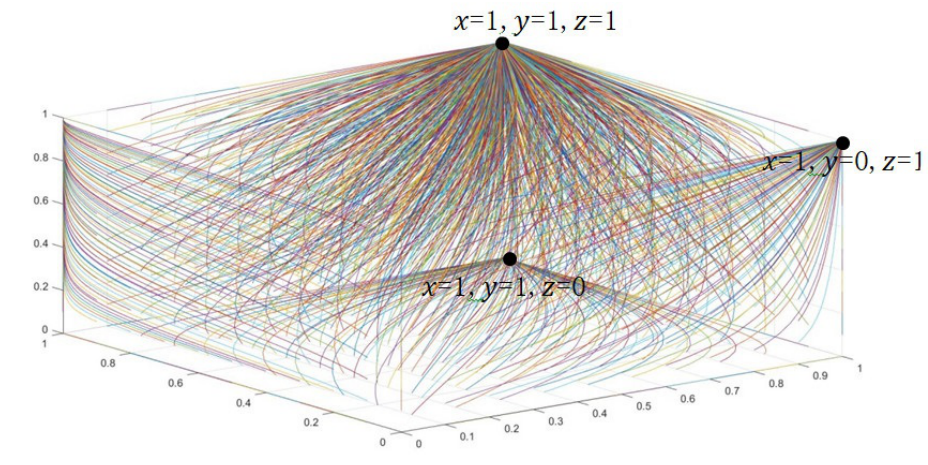
Figure 2. Path of numerical